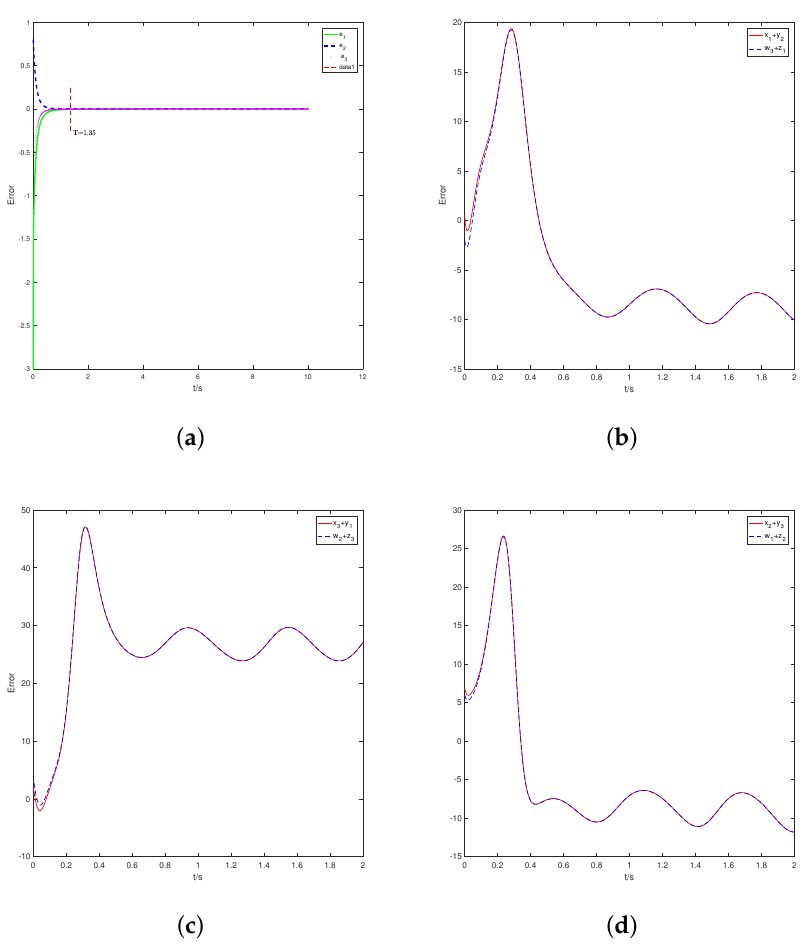
Figure 1. ( a ): The time response of synchronization error of Switch 1, ( b – d ): The state trajectories of Switch 1.